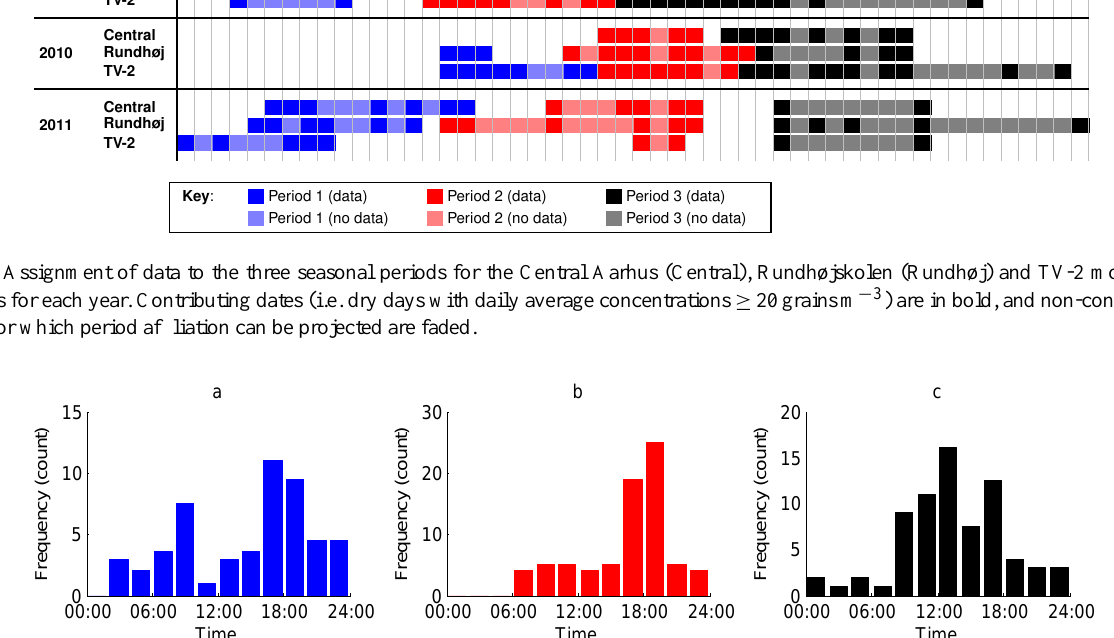
Fig. 3. Peak-time distributions for (a) Period 1 ( n = 37), (b) Period 2 ( n = 58) and (c) Period 3 ( n = 62), where n is number of constituent profiles. Where peaks straddled two time slots, each bi-hourly bin was assigned a value of 0.5.